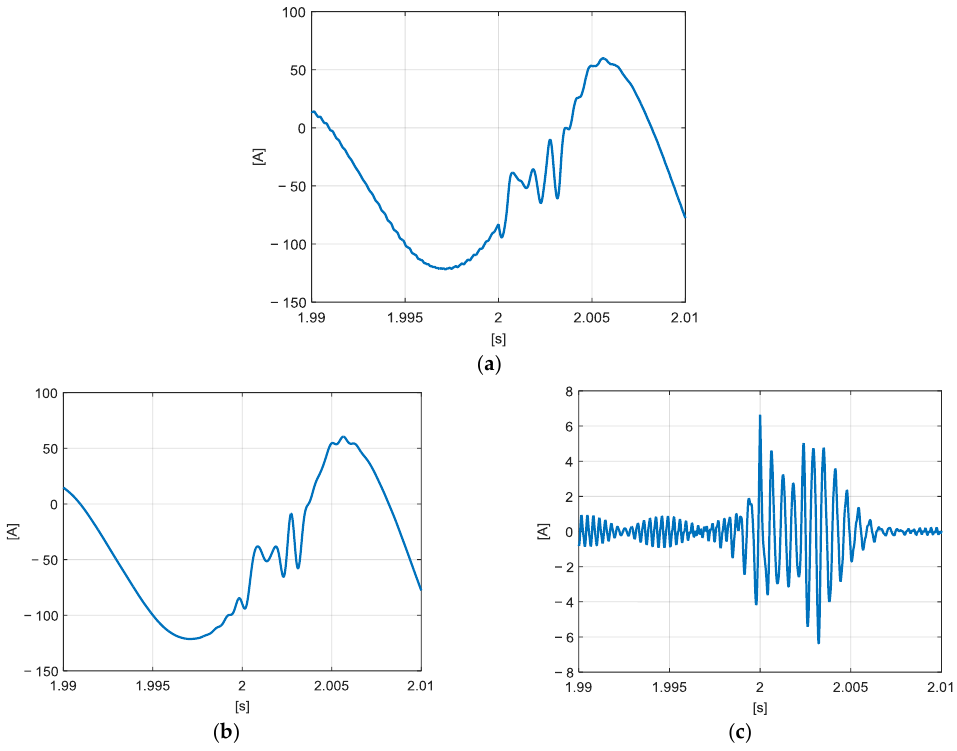
Figure 18. Case study 3: time trends of the waveform under study in terms of ( a ) original waveform, ( b ) low-frequency waveform and ( c ) high-frequency waveform.